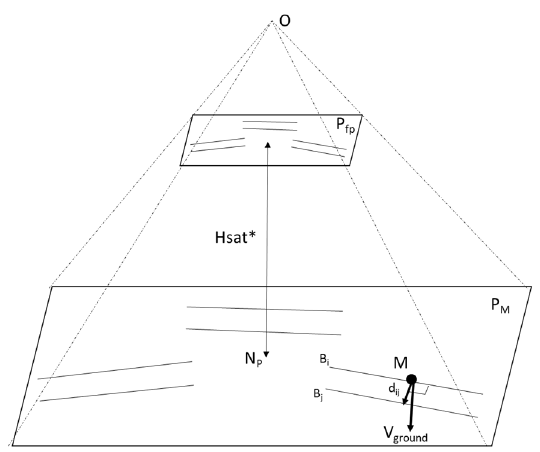
Figure 4 Satellite apparent orbit and ground track. Projection of satellite velocity depends mainly on satellite altitude H sat